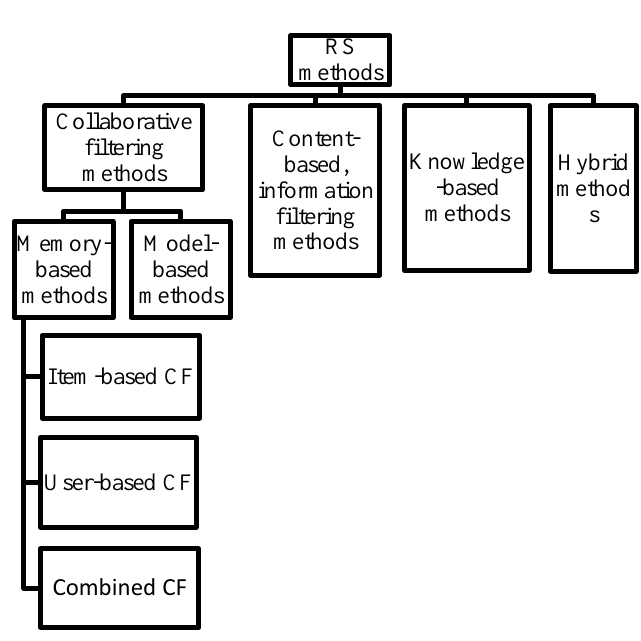
Fig. 1. Recommender system (RS) building